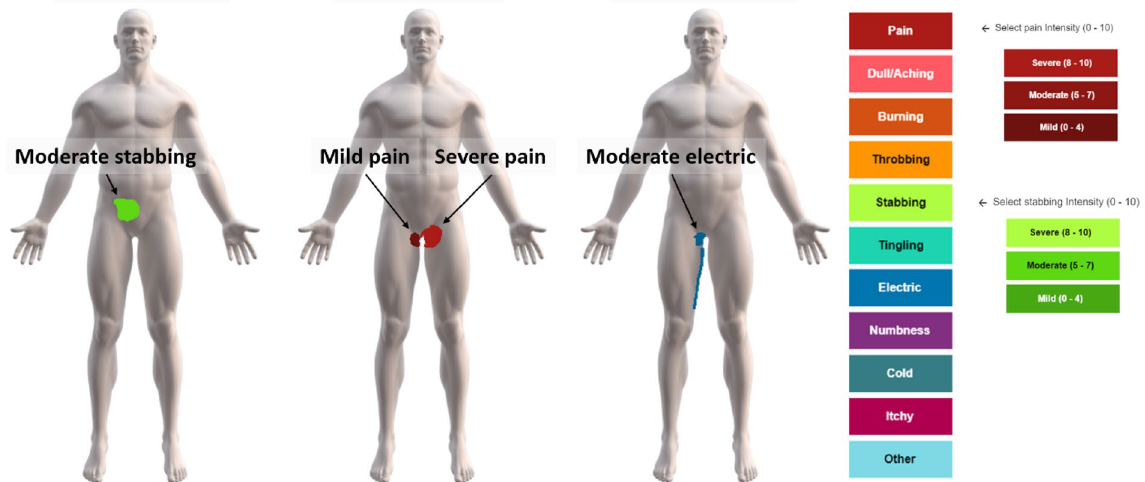
Figure 1. Examples of the anatomically detailed pain charts and individual pain drawings showing different pain quality descriptors, pain intensities, and pain areas. Green indicates the pain quality “stabbing” (2330 pixels), red indicates “pain” (1800 pixels), and blue “electric” (1485 pixels). Colour shading from dark to light indicates pain intensity (mild, moderate,